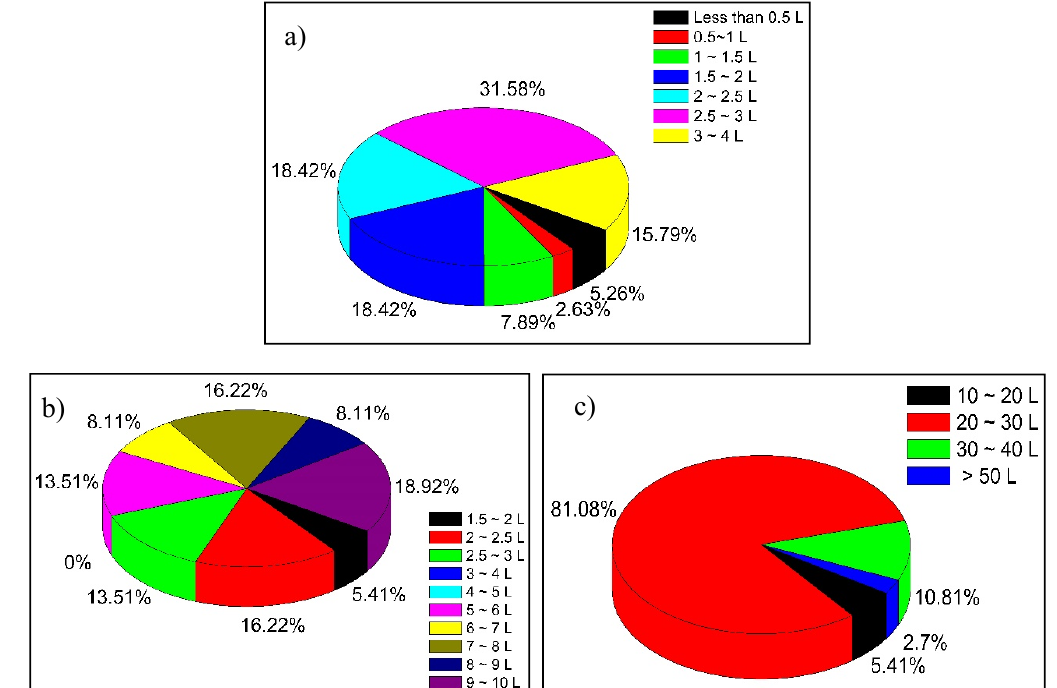
Figure 7. Amount of water, expressed in liters per day, used by the inhabitants for: ( a ) drinking; ( b ) preparing food; and ( c )